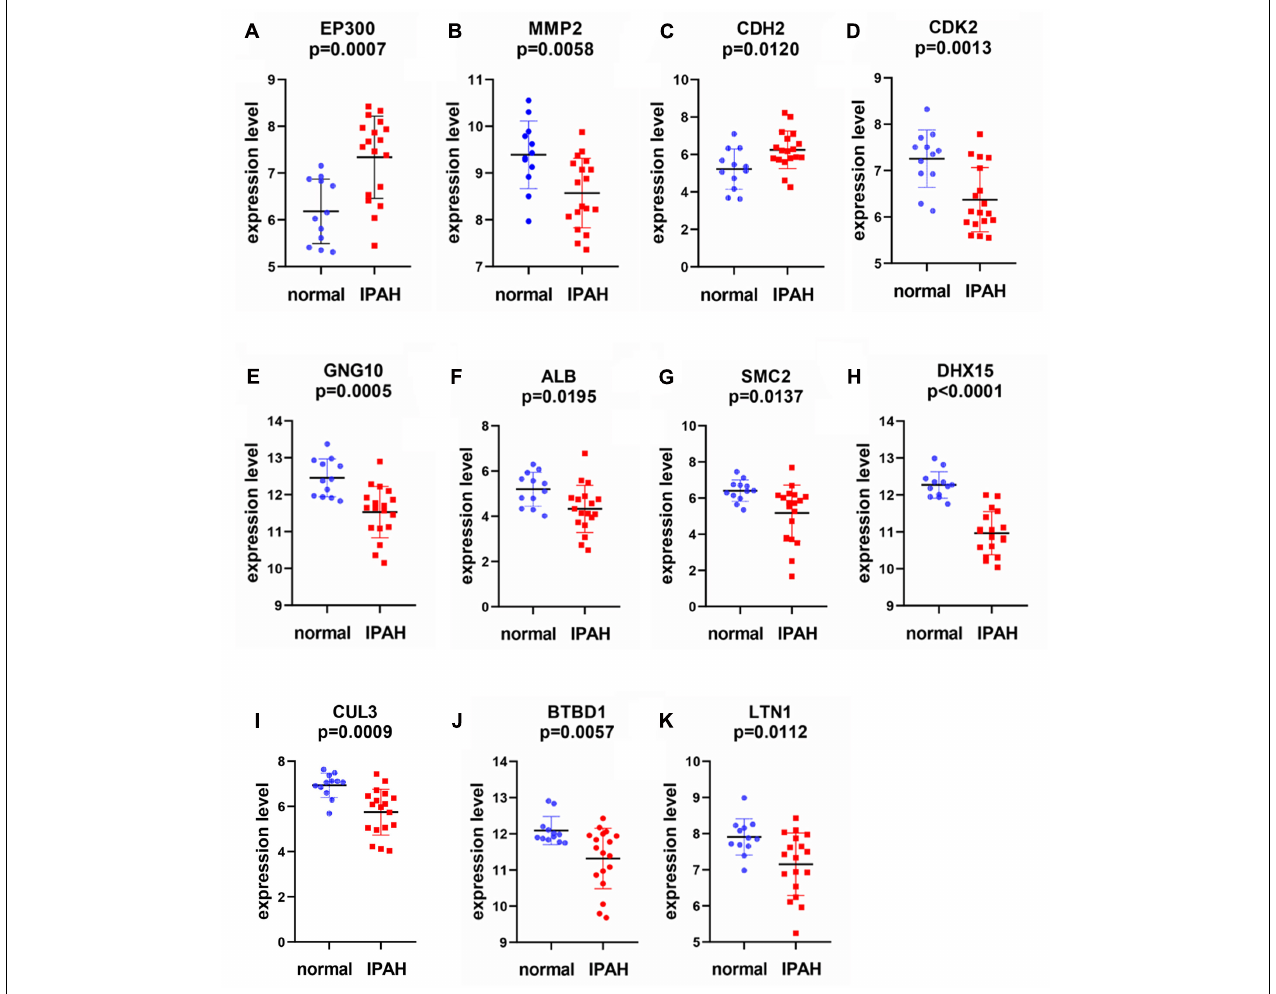
FIGURE 7 | Scatter diagrams for the expressions of real hub genes in GSE15197. (A) EP300 , (B) MMP2 , (C) CDH2 , (D) CDK2 , (E) GNG10 , (F) ALB , (G) SMC2 , (H) DHX15 , (I) CUL3 , (J) BTBD1 , and (K) LTN1 . Each point represents a sample. In GSE15197, there are 18 IPAH samples and 12 normal samples. EP300 , E1A binding protein p300; MMP2 , matrix metallopeptidase 2; CDH2 , cadherin 2; CDK2 , cyclin-dependent kinase 2; GNG10 , G protein subunit gamma 10; ALB , albumin; SMC2 , structural maintenance of chromosomes 2; DHX15 , DEAH-box helicase 15; CUL3 , cullin 3; BTBD1 , BTB domain containing 1; LTN1 , listerin E3 ubiquitin protein ligase